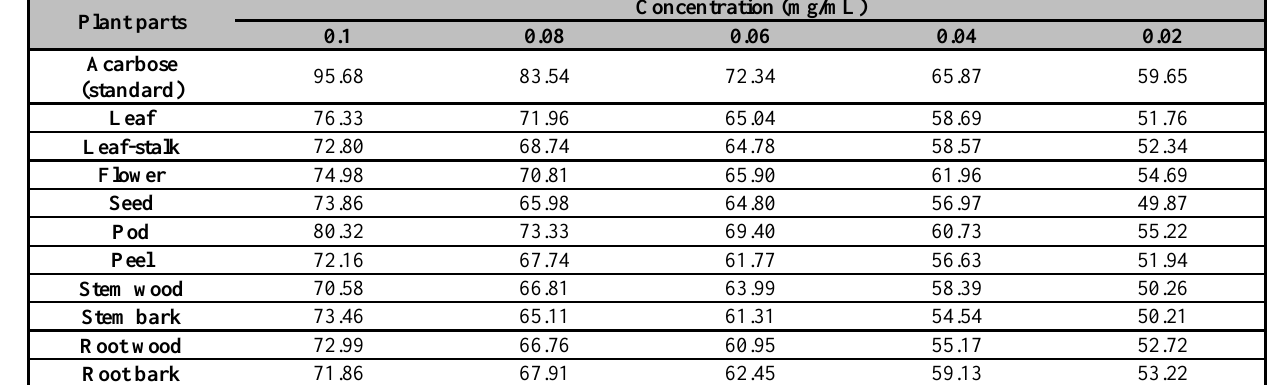
Table 2. Percentage α-amylase inhibition of essential oils from C. Inophyllum